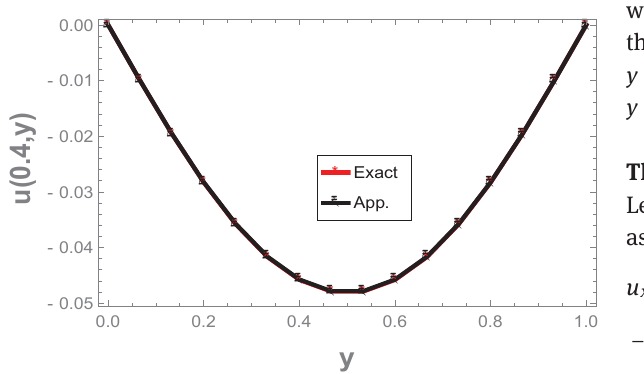
Figure 7: The numerical solutions with the exact solutions at x = 0.4 .